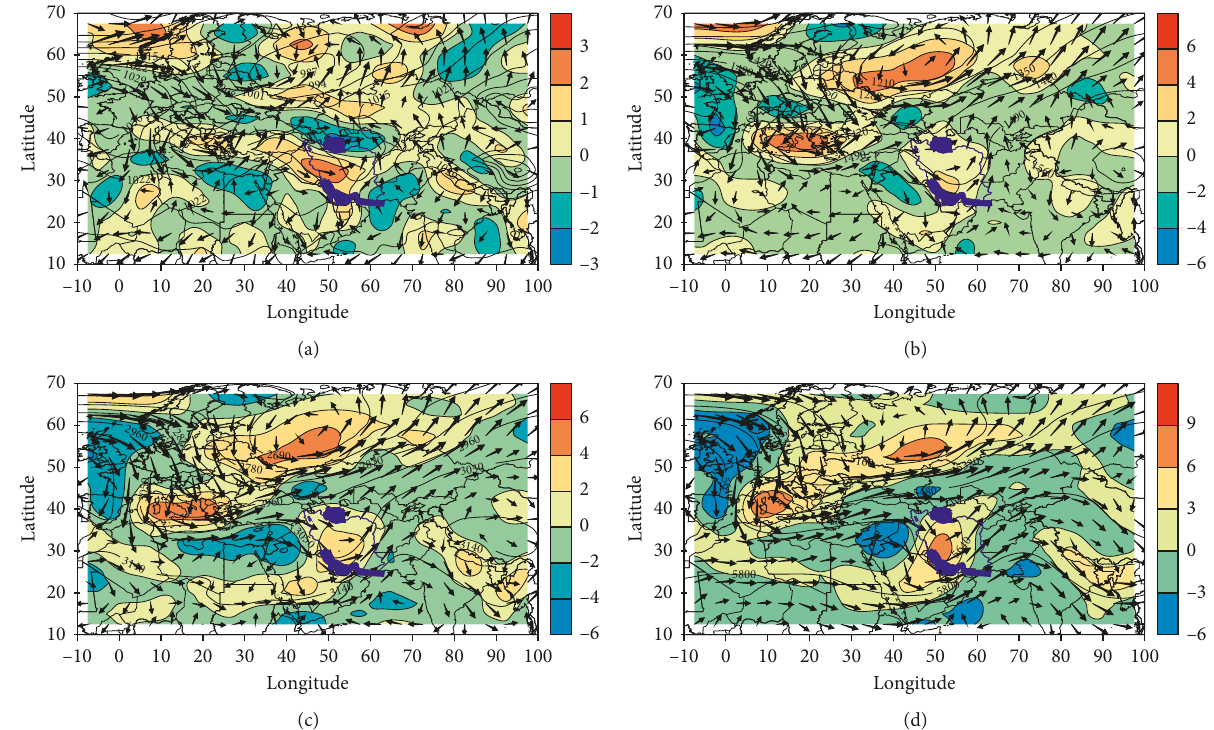
Figure 5: (a) 1000hPa height (contours), vorticity (5 × 10 − 5 ), and wind flow (m/s). (c) 700hPa height (hPa), vorticity (5 × 10 − 5 (5 × 10 − 5 S − 1 and wind flow